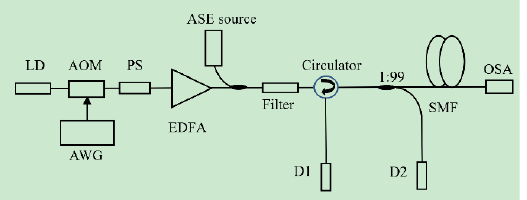
Figure 7. The experimental setup to measure SBS threshold with different repetition rates and ASE noise levels.